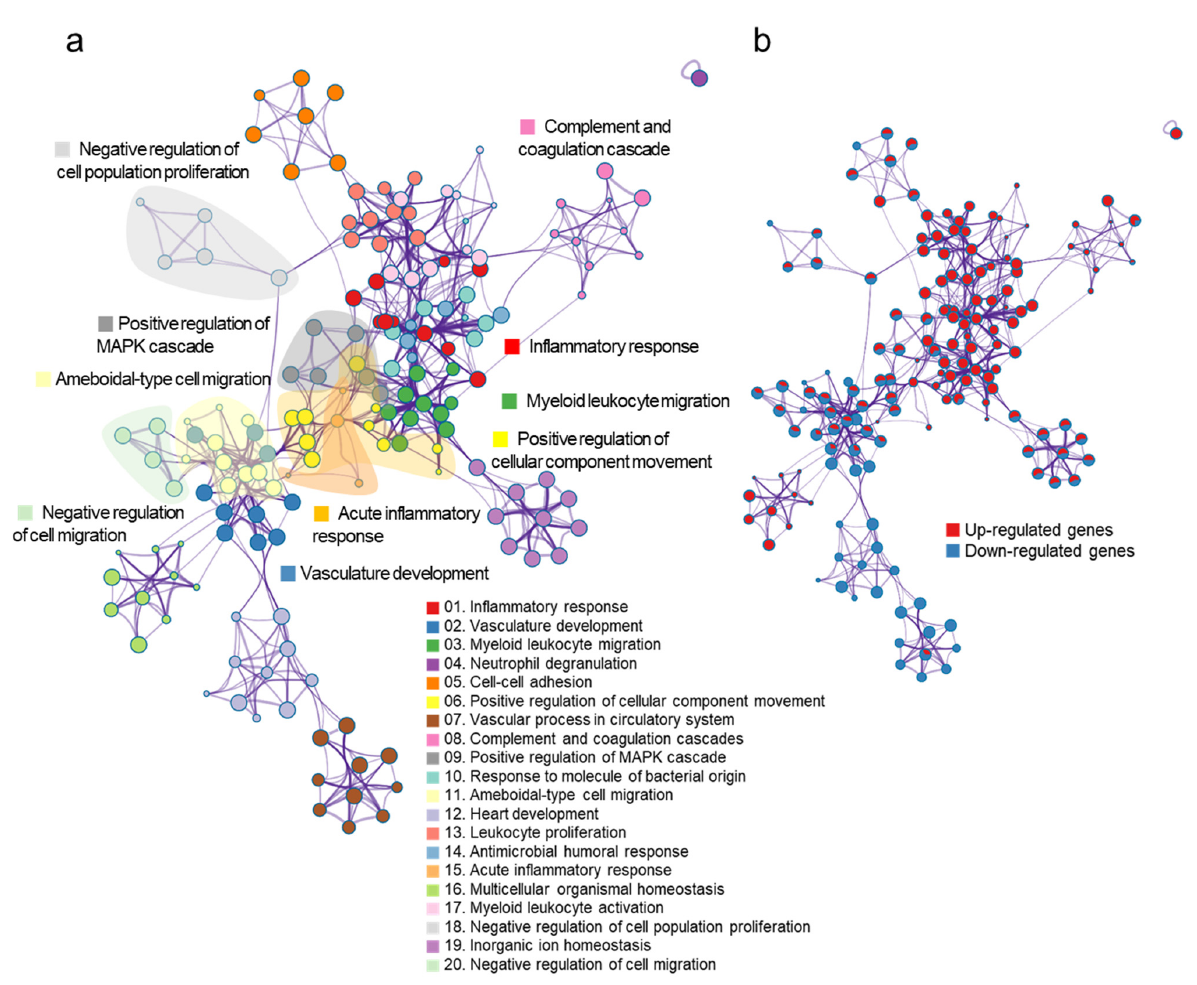
Figure 4. The network of gene sets in the DEGs following PHMG-P treatment. The node in the network indicates a gene set and the edge represents the interaction between gene sets. ( a ) Functional categories of gene sets in the network. The color of the node indicates the functional category of the gene set. ( b ) Expression pattern of gene sets in the network. The node color represents the expression information of the gene set. Red colors indicate the upregulated gene sets and blue colors indicate the downregulated gene sets.